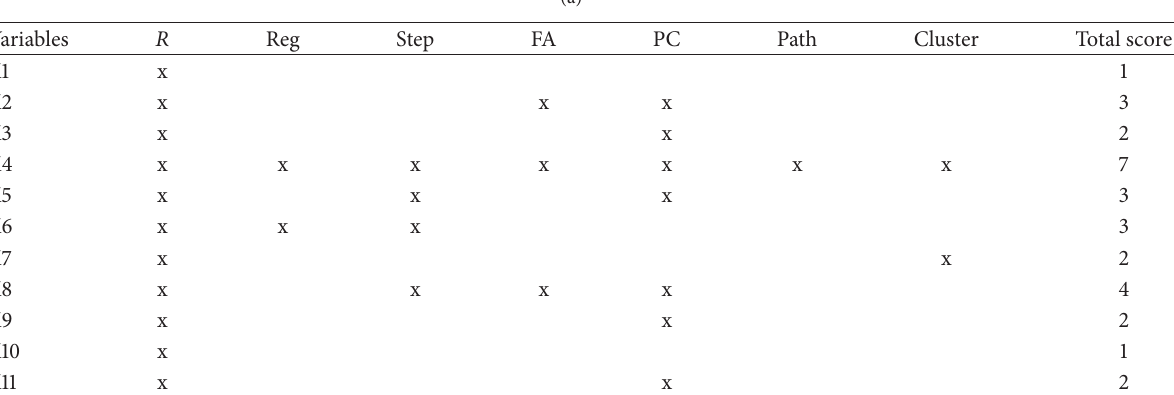
Table 11: (a) Wheat characteristics identified as crucial in wheat grain yield with each one of the used statistical techniques under inoculation condition and different water levels. (b) Wheat characteristics identified as crucial in wheat grain yield with each one of the used statistical techniques under noninoculation condition and different water